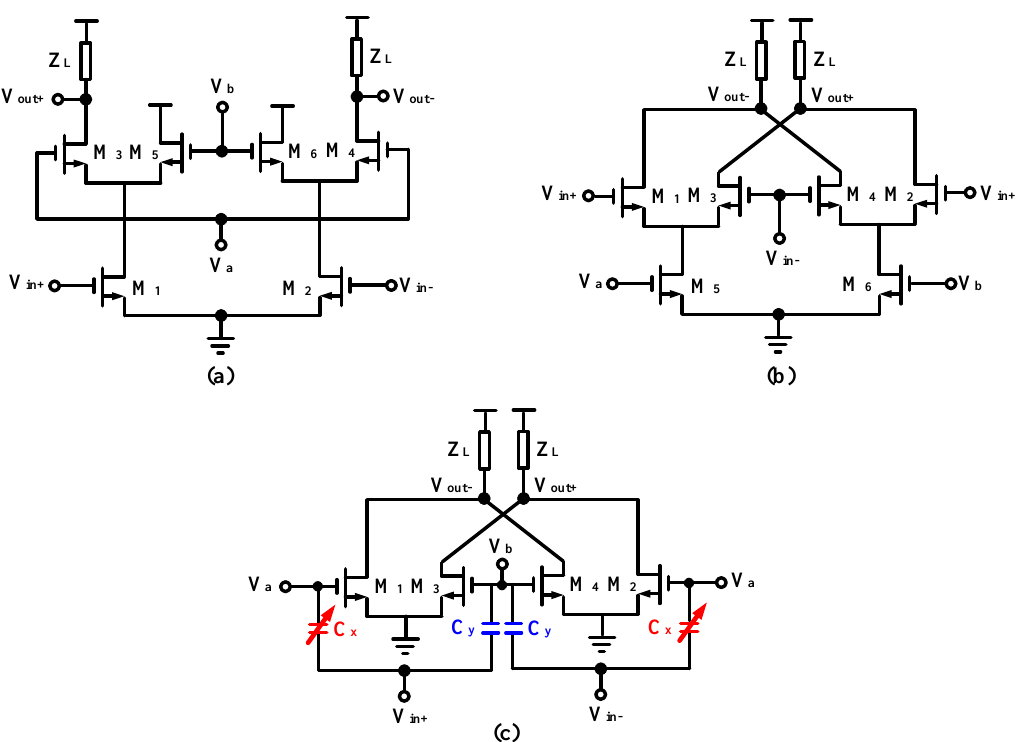
Figure 1. Commonly used mm-wave VGA structures: ( a ) classic current-steering VGA with two- stack transistor structure; ( b ) classic Gilbert-cell-based VGA with two-stack transistor structure; ( c ) proposed CS VGA with stackless transistor